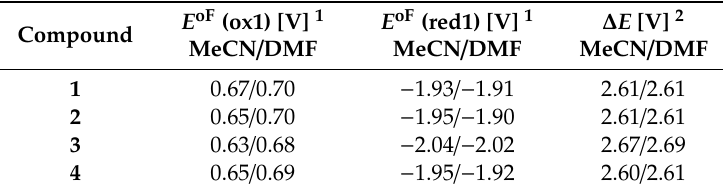
Table 2. Electrochemical data of studied ferrocene